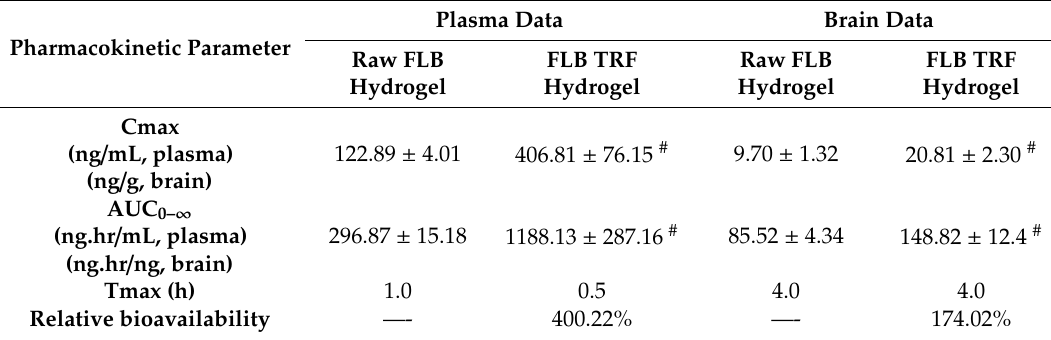
Table 3. Pharmacokinetic parameters following intranasal administration of optimized FLB TRF hydrogel compared to raw FLB control